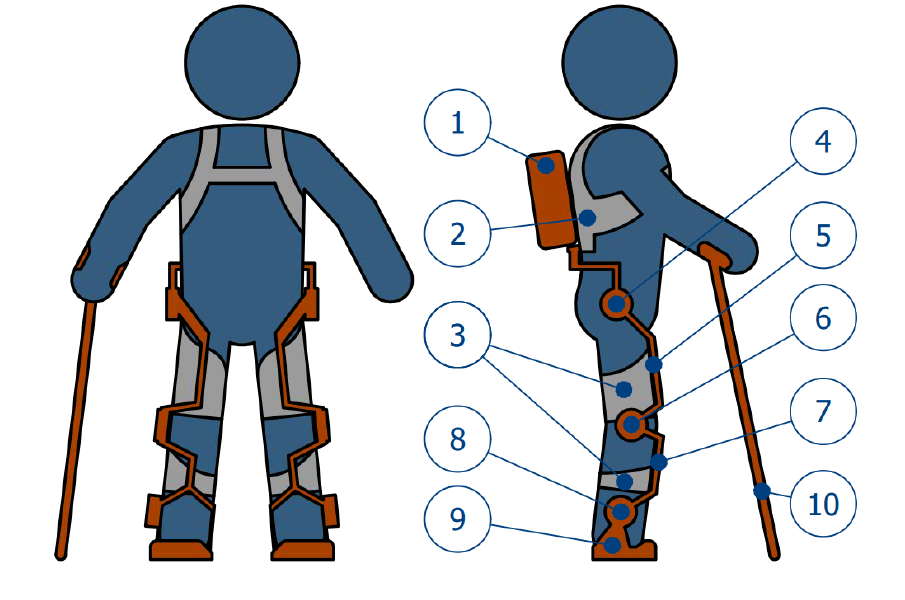
Figure 1. exoskeleton components: (1) power pack; (2) trunk attachments; (3) limbs attachments; (4) hip joint; (5) upper leg frame; (6) knee joint; (7) lower leg frame; (8) ankle joint; (9) foot frame; (10) instrumented